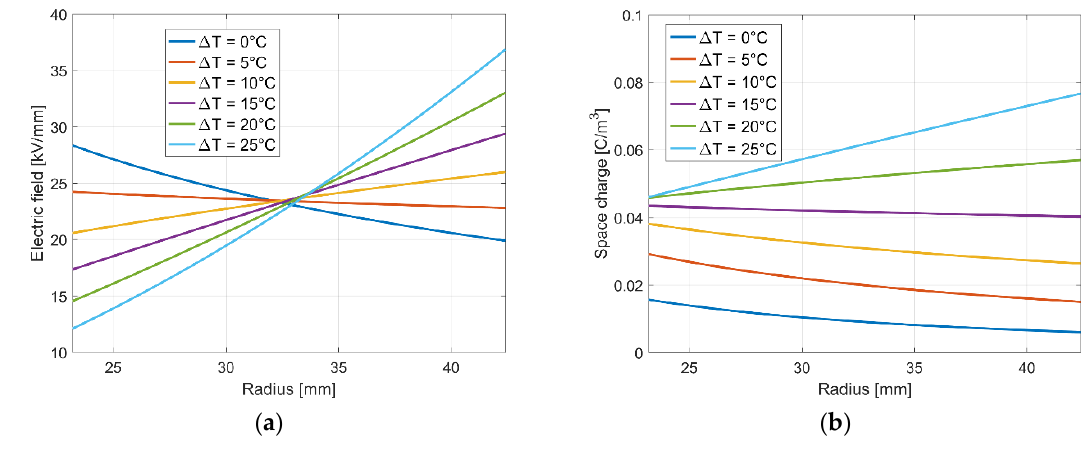
Figure 8. ( a ) Stationary electric field within a MI insulation; ( b ) corresponding space charge distribution [11,22].